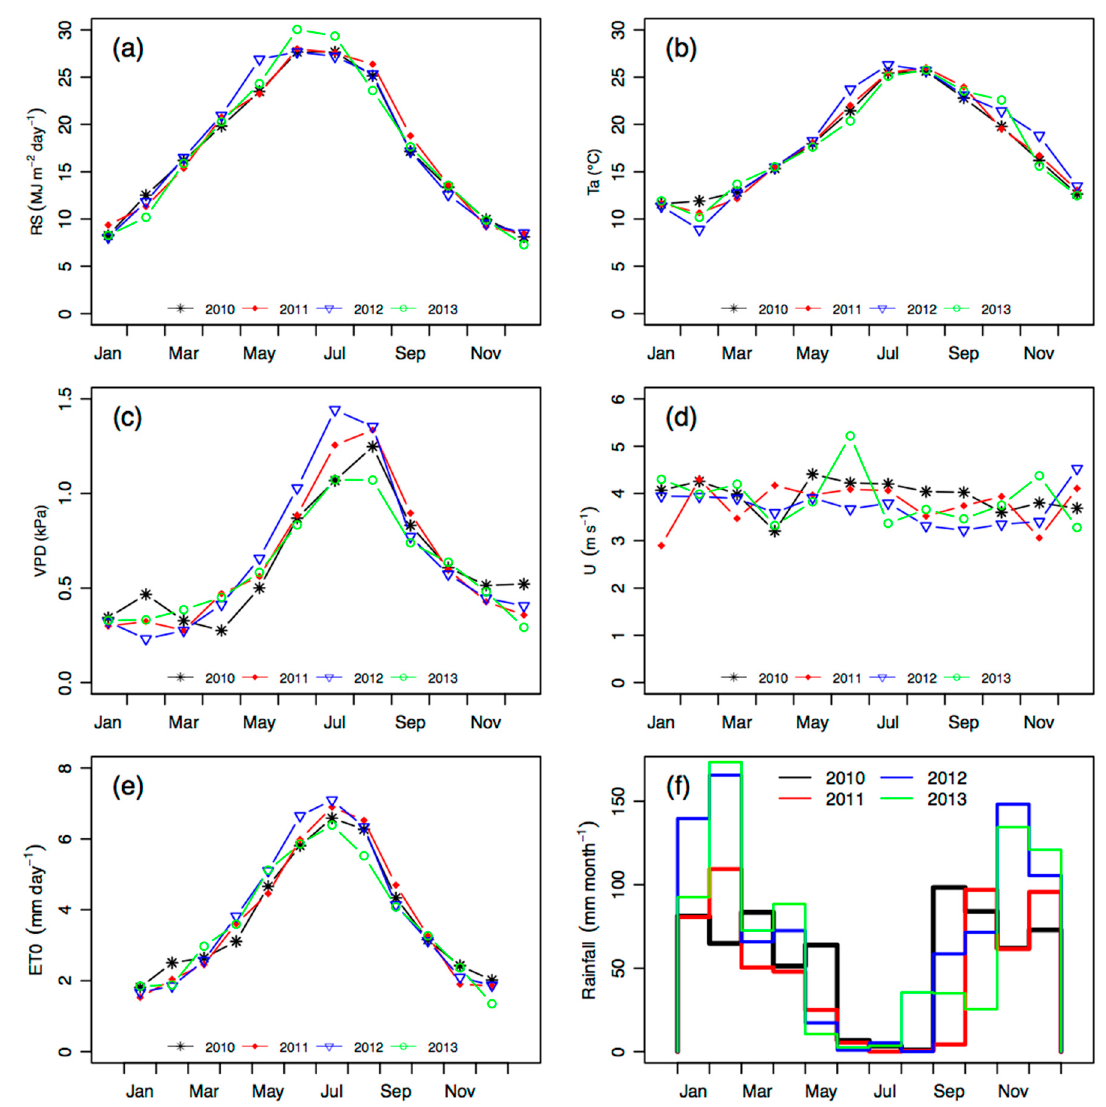
Figure 2. Climatic conditions during the four years of the experiment, recorded at the meteorological station: ( a ) Incoming solar radiation; ( b ) air temperature; ( c ) water vapour deficit; ( d ) wind speed; ( e ) reference evapotranspiration; ( f ) rainfall amounts. Values in ( a – e ) are the monthly averages, values in ( f ) are cumulated rainfall